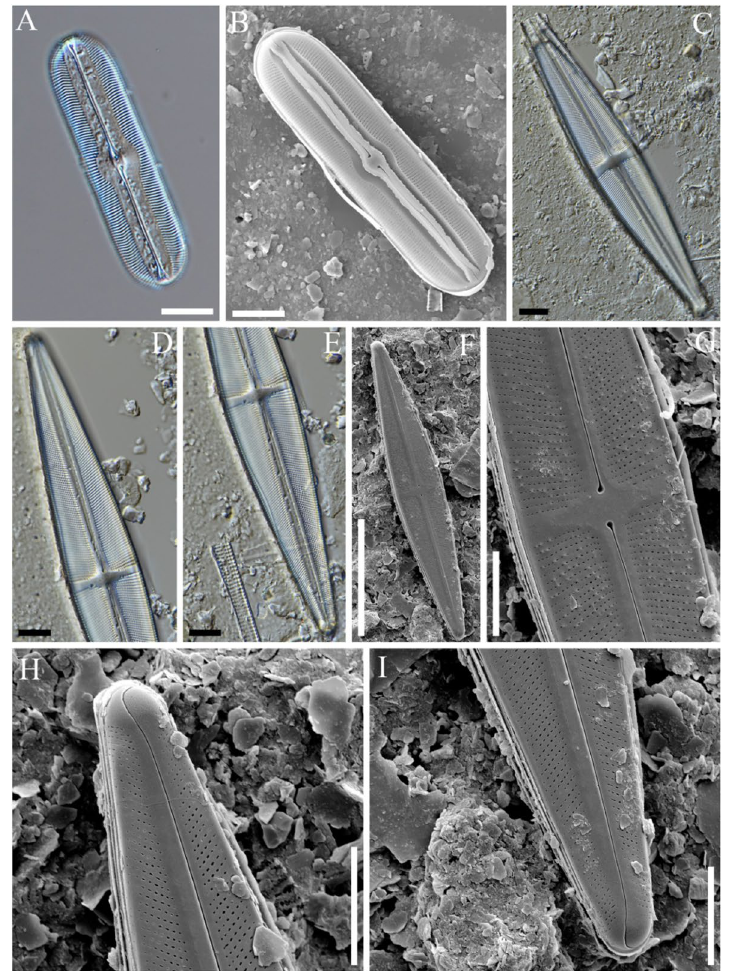
Fig. 5 Light ( A , C , D , E ) and field emission scanning electron ( B . F – I ) photomicrographs of diatoms collected from the sediment core at sampling site GG19‑01. ( A , B ) Sellaphora labda var. nipponica . ( C – I ) Stauroneis angustilancea . Scale bars: A–E,